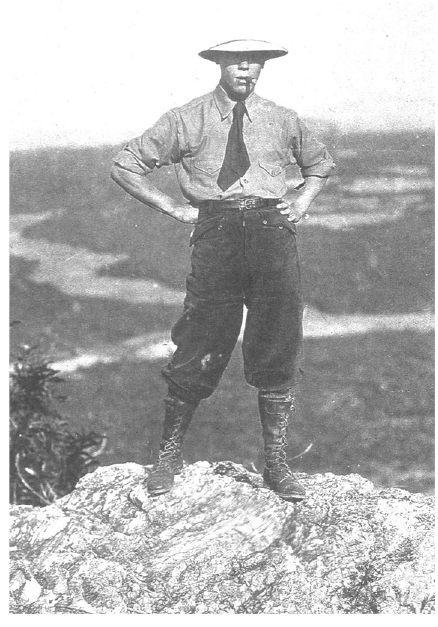
Figure 4. A photo shows Prof. Huan-Yong Chen was collecting plant specimens in Hainan Province in